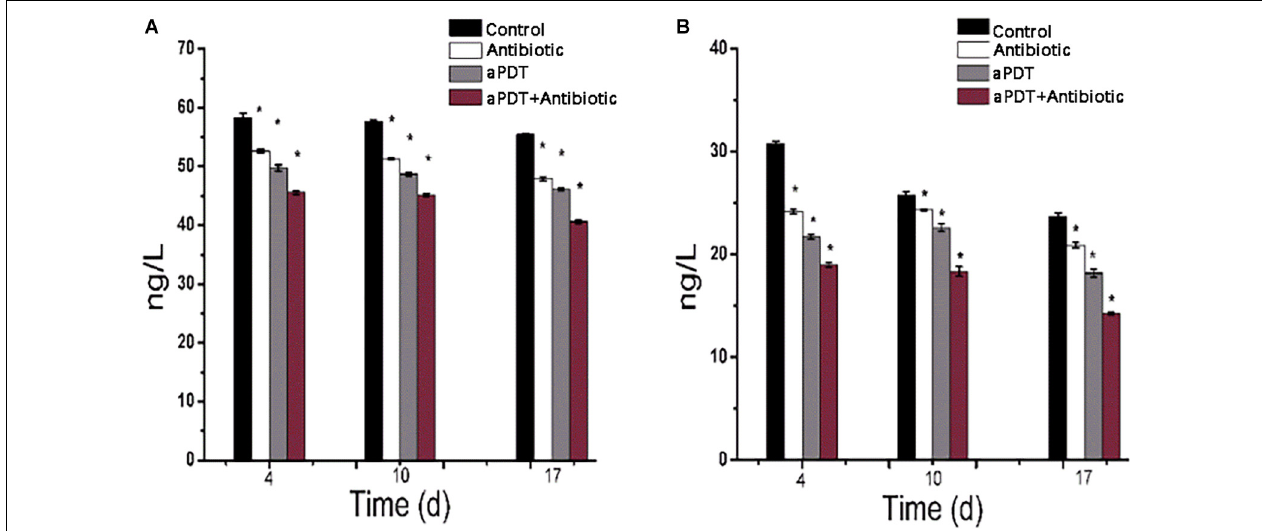
FIGURE 10 | Expression of TNF- α and IL-6 as determined by ELISA in burn wound tissue of rats. (A) TNF- α levels at 4, 10, and 17 days after infection. (B) IL-6 levels at 4, 10, and 17 days after infection.